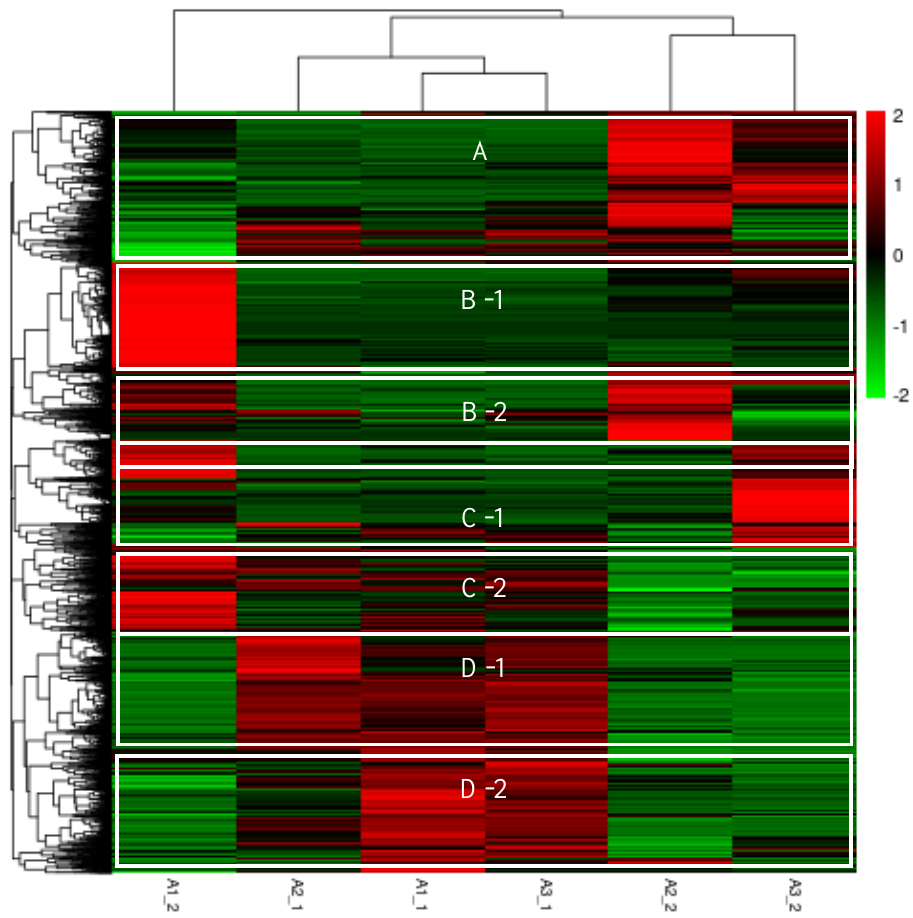
Figure 5. Hierarchical cluster analysis of genes differentially expressed in response to exogenous NAA treatment under Cd stress. This map shows the genes of log 2 (fold change) values of the NAA effects on the shoot and root. Colors represent changes in gene expression levels: red means up, and green means down. The combined gene expression patterns were grouped into four major clusters, which were designated Clusters A, B, C, and